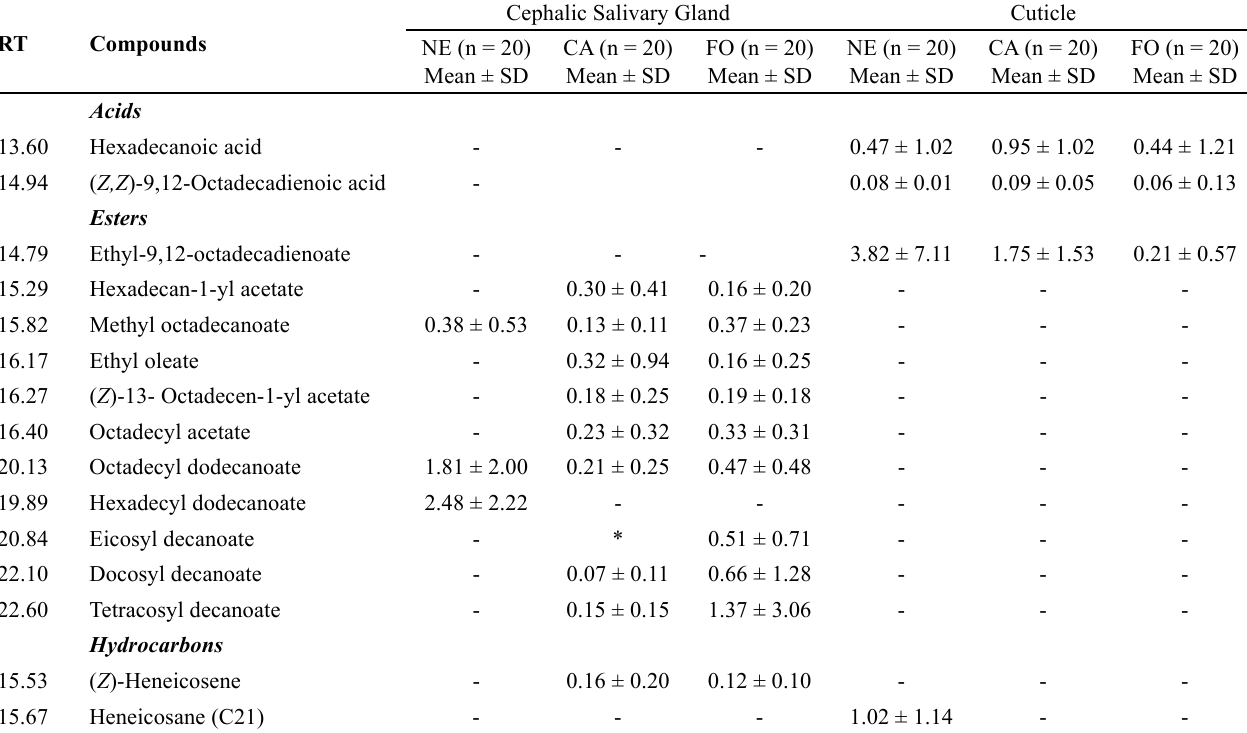
Table 1 . Mean and standard deviation (SD) of relative concentration (%) of the compounds from cephalic salivary gland secretion and cuticle of workers of Melipona quadrifasciata